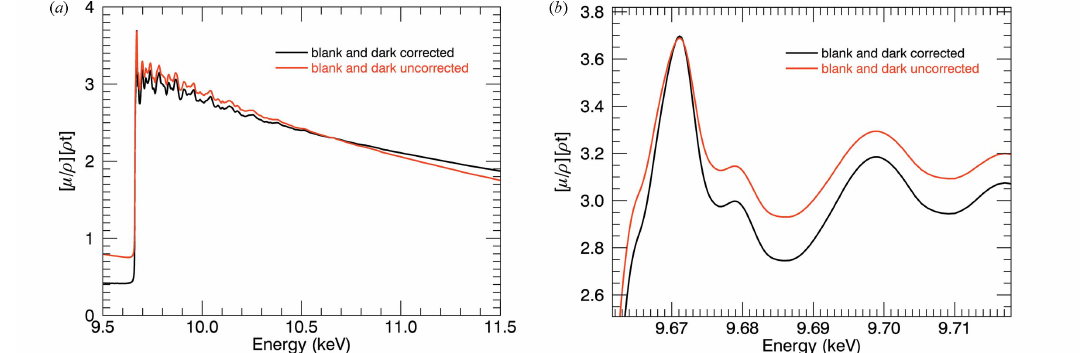
Figure 7 Changes to the 10 K absorption spectra, for the 10 m m foil, due to dark current and blank corrections. ( a ) Changes to the shape of the slope, pre-edge and edge-jump. ( b ) The near-edge structure shows significant change in form for processed data with sharper